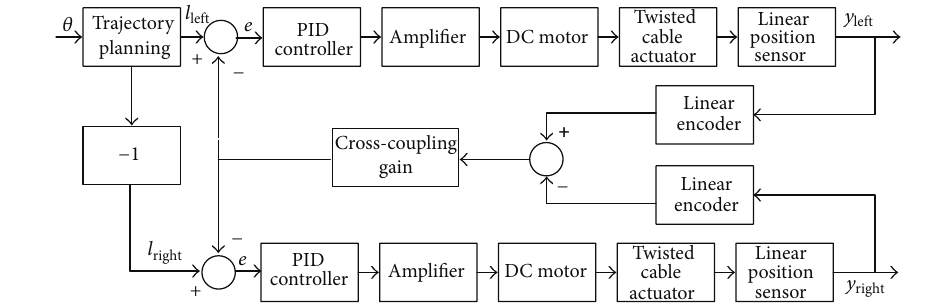
Figure 10: Block diagram of PID-FC controllers.